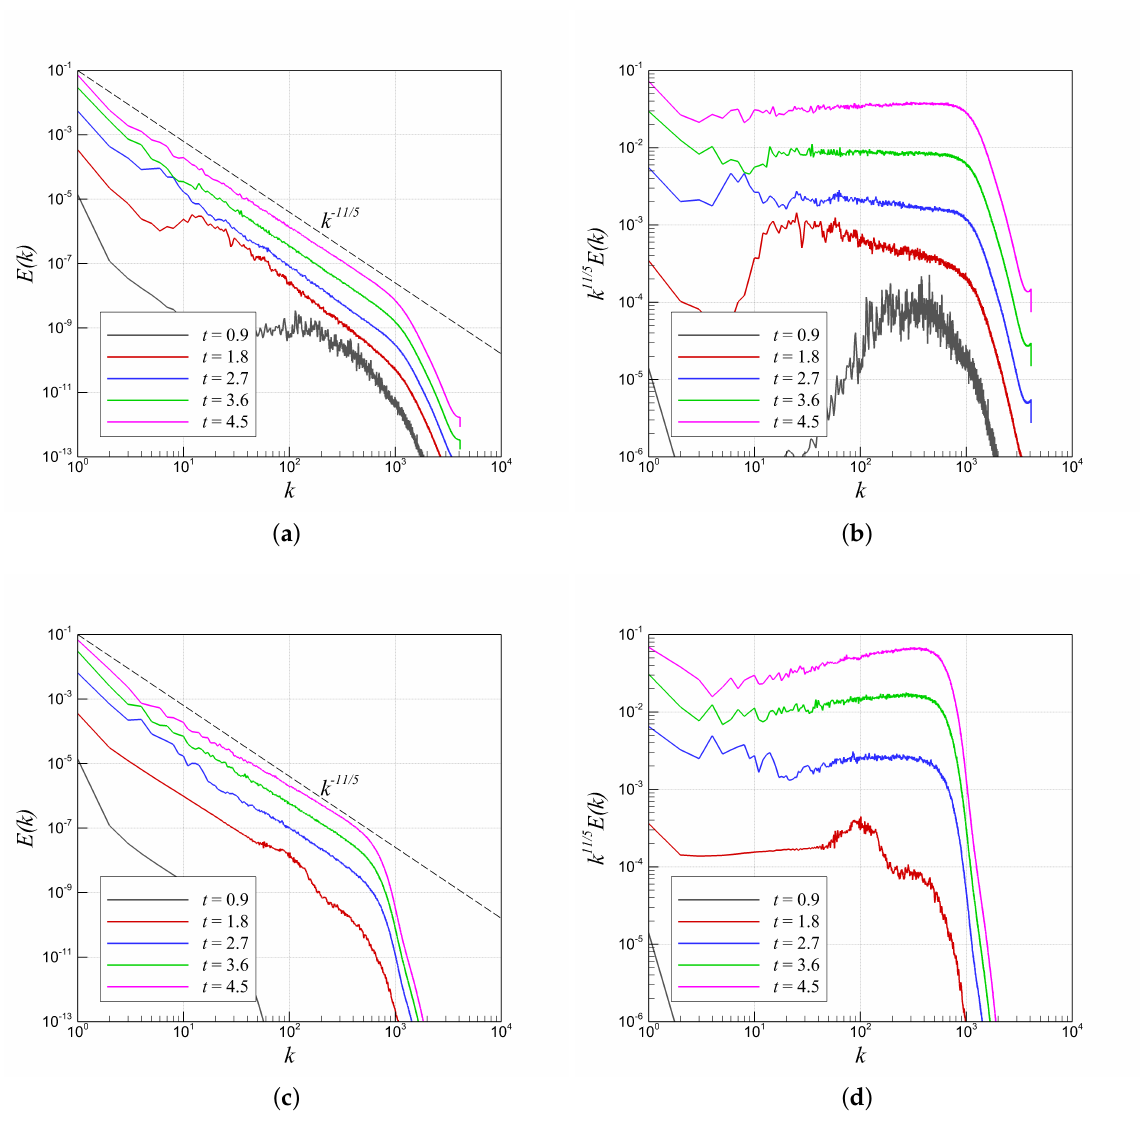
Figure 20. Time evolution of density-weighted kinetic energy spectra and compensated density- weighted kinetic energy spectra for the RTI problem with single-mode perturbation obtained using different modeling approaches at a resolution of 8192 × 24576; ( a ) density-weighted spectra using ILES-Roe solver; ( b ) compensated density-weighted spectra using ILES-Roe solver; ( c ) density-weighted spectra using CS+RF ( σ = 1.0) solver; ( d ) compensated density-weighted spectra using CS+RF ( σ = 1.0)